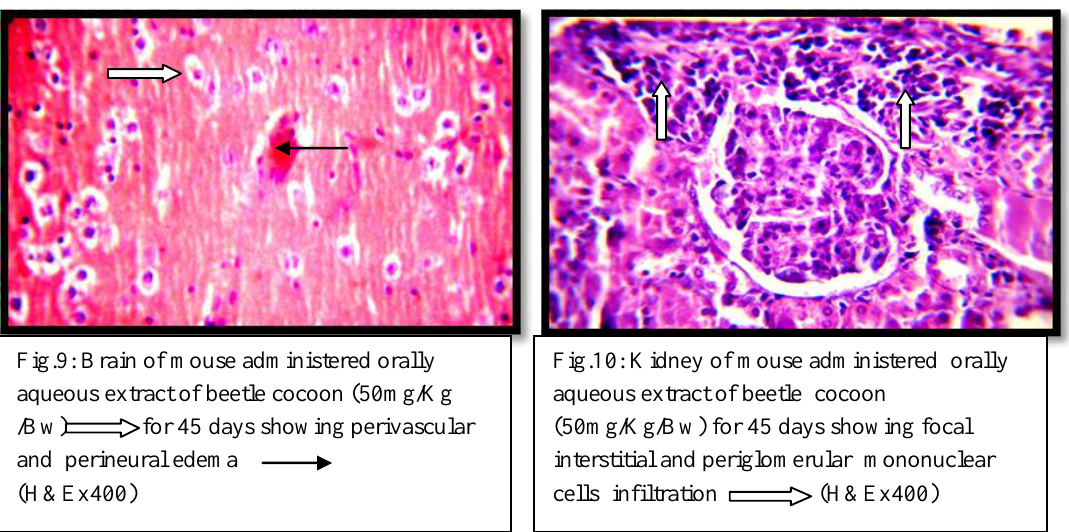
Fig.9: Brain of mouse administered orally aqueous extract of beetle cocoon (50mg/Kg